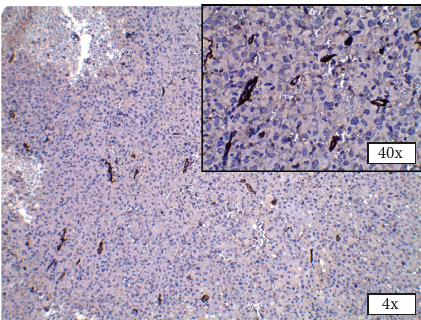
Figure 4: Immunohistochemistry CD34. Tumor cells negative for CD34, 4x, and 40x (inset).